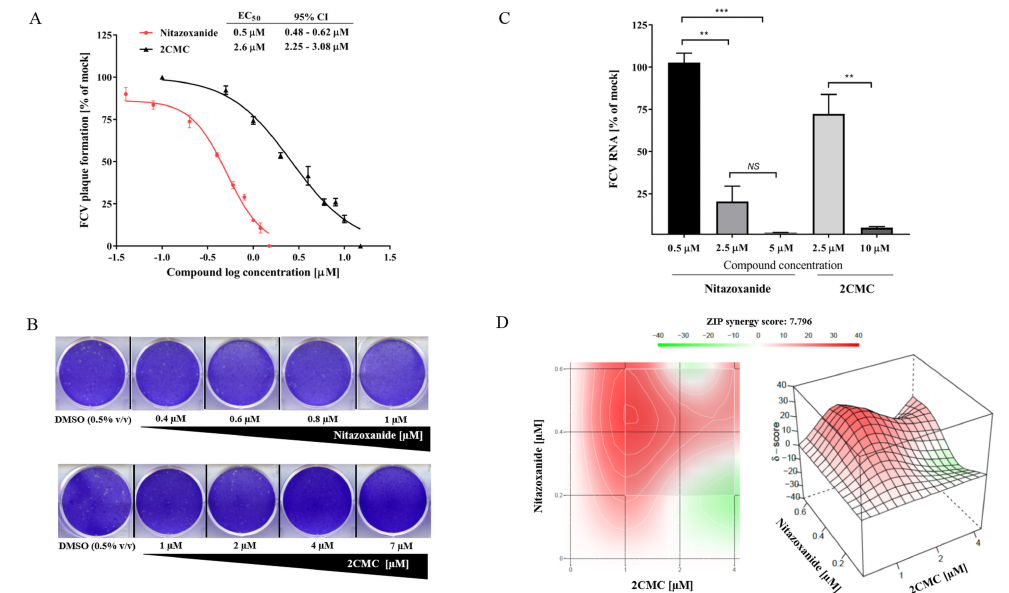
Figure 4. The antiviral activity of 2CMC and nitazoxanide against FCV in the cell culture. ( A ) The EC 50 values of 2CMC and nitazoxanide against FCV calculated by fitting the dose-response curves from a plaque reduction assay. ( B ) Plaque reduction assay results are shown, with the negative control (vehicle only), nitazoxanide (0.4–1 µ M), and 2CMC (1–7 µ M). ( C ) Nitazoxanide and 2CMC effects on FCV replication. CRFK cells were infected with FCV (MOI 0.0005) and subsequently treated with different concentrations of both compounds. After 24 h of incubation, FCV RNA copy numbers were determined by RT-qPCR and the relative percentage of RNA copies in relation to mock are plotted. ( D ) The combined inhibitory effects of nitazoxanide (0 to 0.6 µ M) and 2CMC (0 to 4 µ M) were tested over a range of combinations against FCV in the cell culture using the plaque reduction assay. A dose-response matrix was generated and analyzed for synergy using SynergyFinder. The ZIP mode synergy score is presented as the average of all δ -scores across the dose-response landscape, and the peaks above the plane of 0% synergy in the plot indicate synergism. Nitazoxanide and 2CMC displayed a synergistic antiviral effect against FCV. Data were analyzed using an unpaired t-test. ** p < 0.01; *** p < 0.001; NS , not significant. Duplicate (panels C and D) or triplicate values (panels A and B) from at least two independent experiments are presented, and the mean ± SEM are shown for panels A and